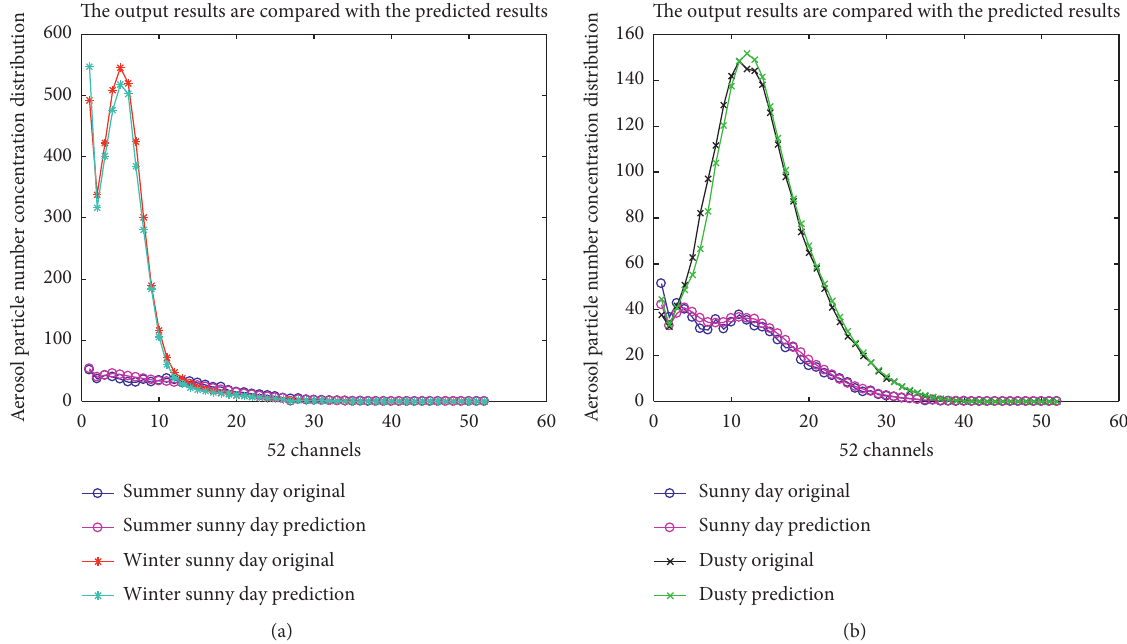
Figure 6: The comparison between prediction results and measured results on summer sunny days, winter sunny days, and dusty days based on BP neural network.